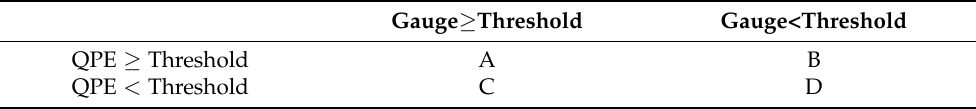
Table 3. Contingency table of gauge and Quantitative Precipitation Estimates (QPE)